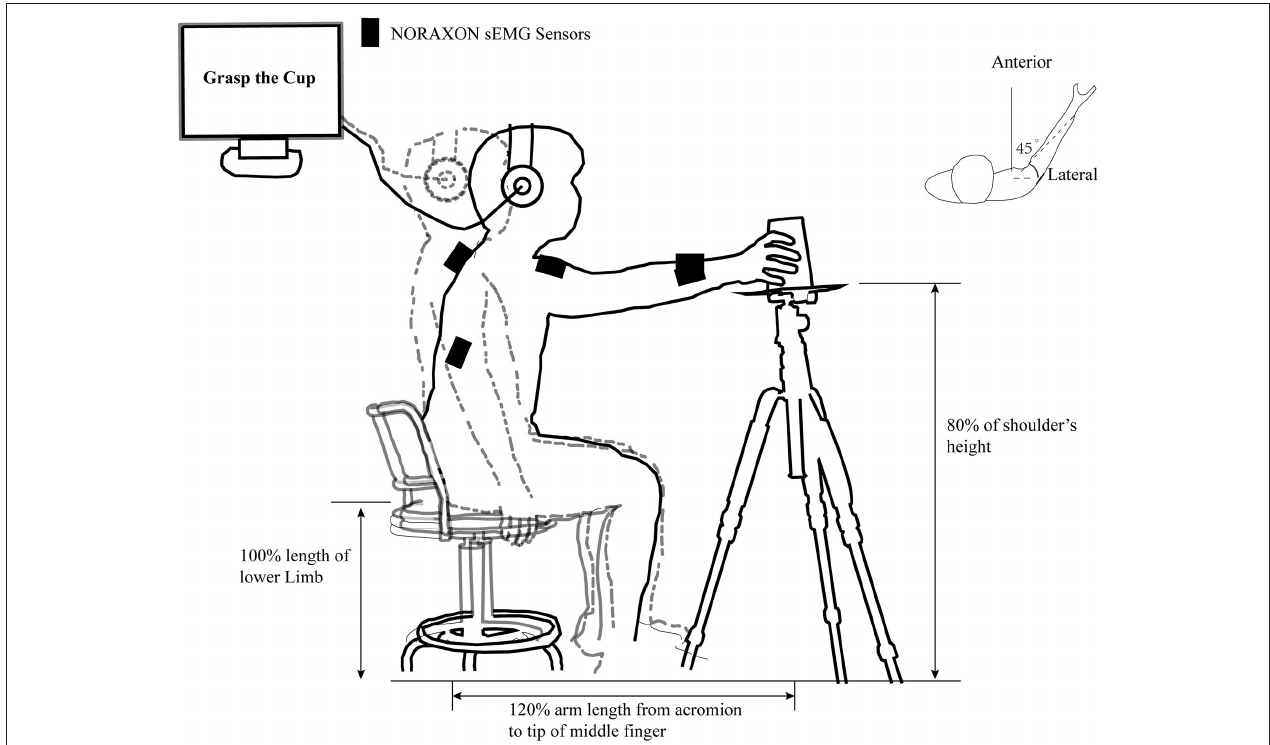
FIGURE 1 | An illustration of the task “reach to grasp a cup” in our study. The outline of the human body in the gray dashed line and the black solid line represent the position of the subject in the pre-motor preparation and motor execution phases in the “reach to grasp a cup” task, respectively. The black rectangle represents the position where the infinite surface EMG sensors is placed. The individually adjusted seat height, the relative position of the cup, and the acromion of movement side are clearly marked. The computer-generated “Warning” and “Go” cues were communicated to the subject through a